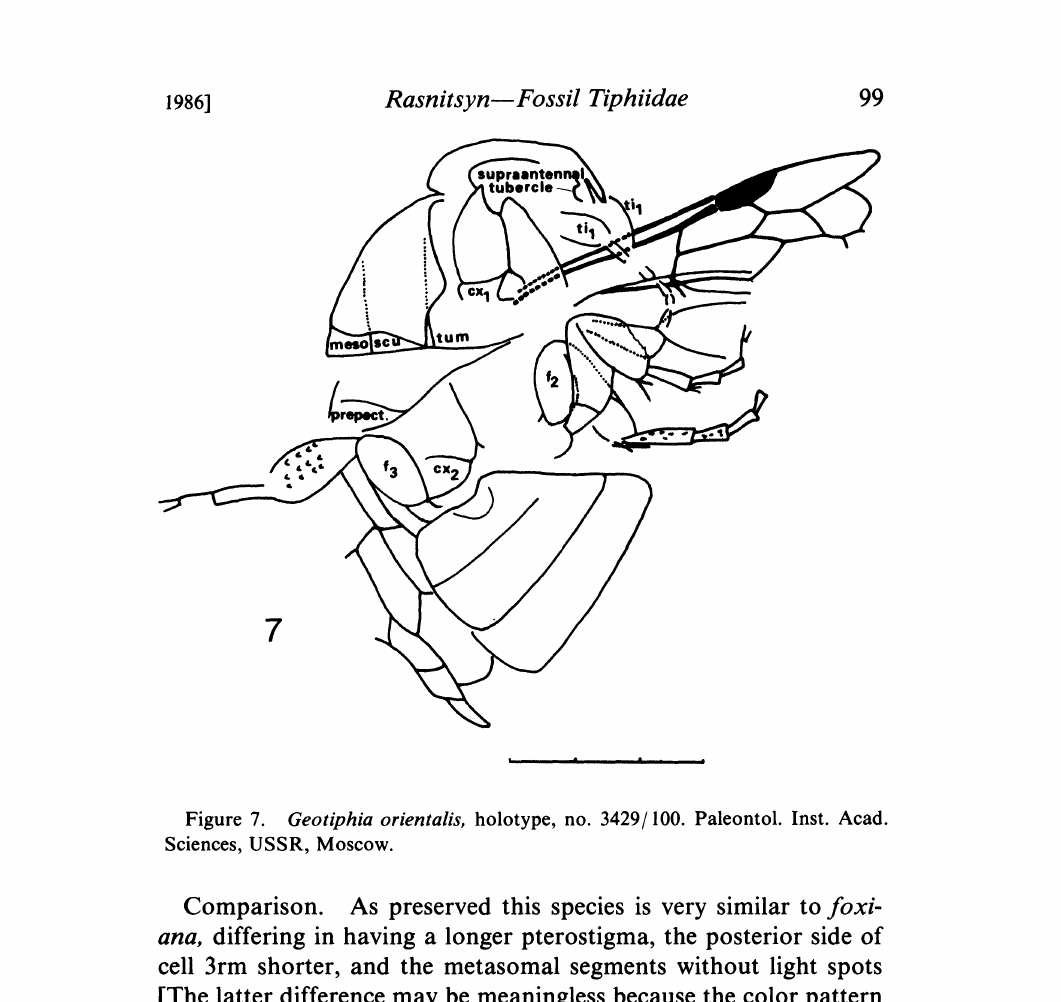
Figure 7. Geotiphia orientalis, holotype, no. 3429/100. Paleontol. Inst. Acad. Sciences, USSR,